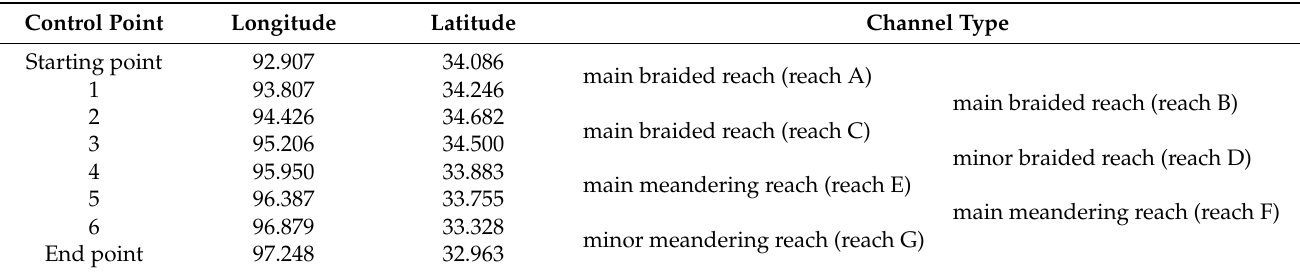
Table 1. Control points of the Tongtian